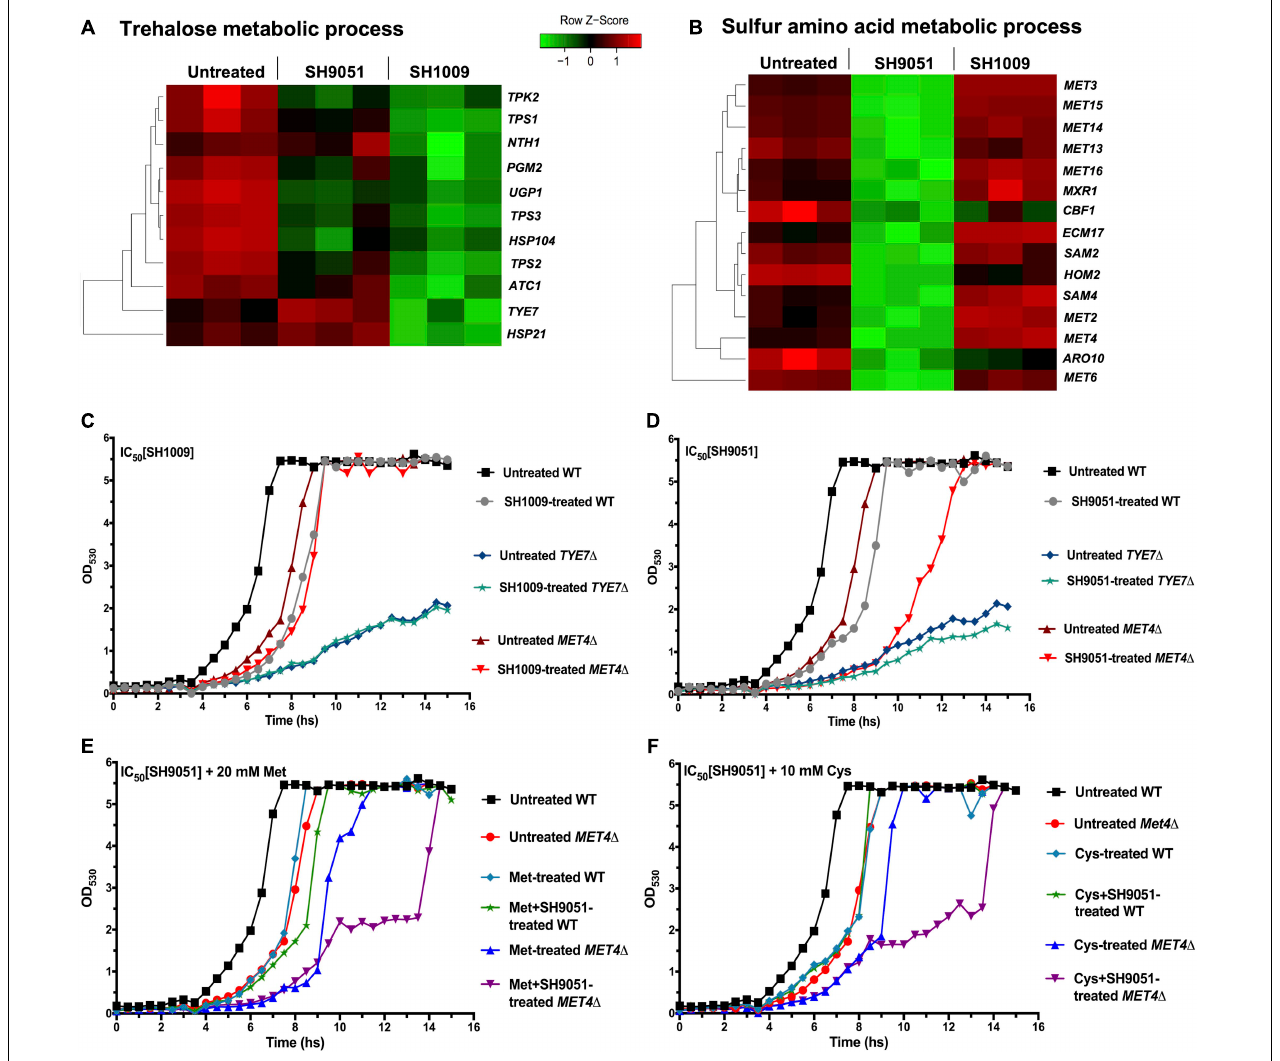
FIGURE 6 | The most repressed transcriptional responses of aurones SH1009 and SH9051 treatments. (A,B) Aurone SH1009 and SH9051 treatments resulted in down-regulation of trehalose and sulfur amino acid metabolic processes. The relative expression of the genes of these processes was illustrated by green–red color scale in heatmap. (C,D) The growth curves of C. albicans SC5314 wild-type strain, TYE7 (cid:49) , and MET4 (cid:49) mutants under the IC 50 concentrations of aurone SH1009 (16 µ M) and SH9051 (90 µ M), respectively. (E,F) The growth curves of C. albicans SC5314 wild-type strain and the MET4 (cid:49) mutant under the IC 50 concentration of aurone SH9051 (90 µ M) with supplements of 20 mM methionine and 10 mM cysteine, respectively. The growth conditions were in YPD broth media at 30 ◦ C using the Bioscreen C growth curve instrument with OD 530 reads recorded at 30 min intervals for 24 h